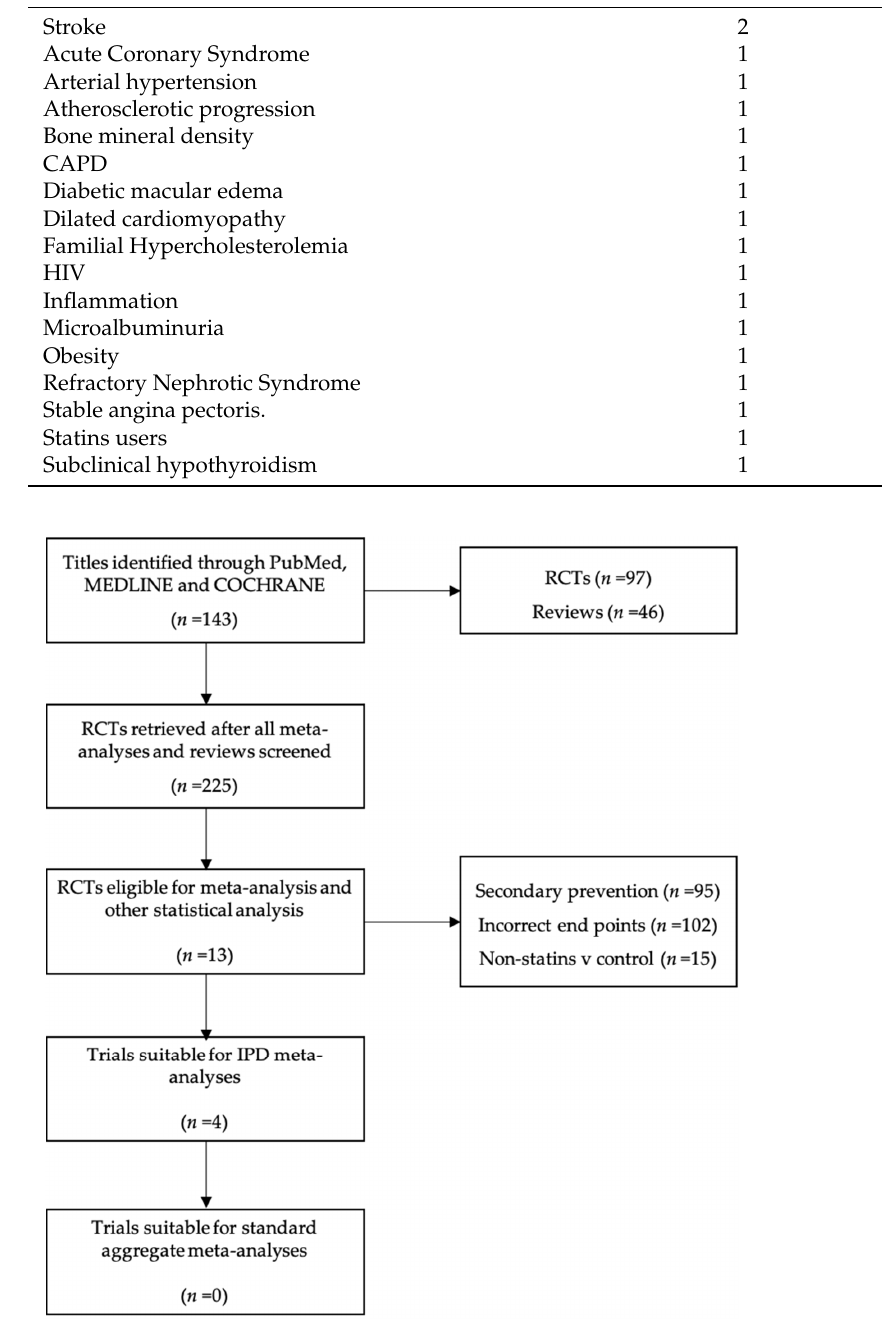
Figure 1. Trial workflow.